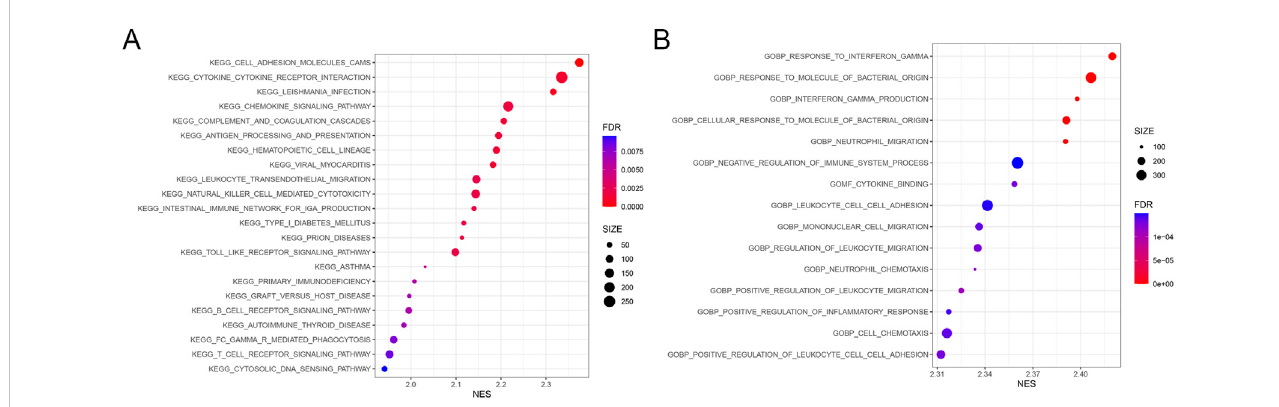
FIGURE 3 Results from gene set enrichment analysis. The size and color of the bubble represent the number of genes enriched in the pathway/function and the statistical signi fi cance, respectively. (A) 22 KEGG pathways. (B) Top 15 GO cellular functions. FDR, false discovery rate; NES, normalized enrichment score.